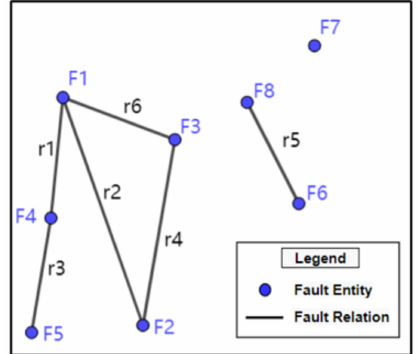
Figure 15. Schematic diagram of structure diagram of complex fault model.